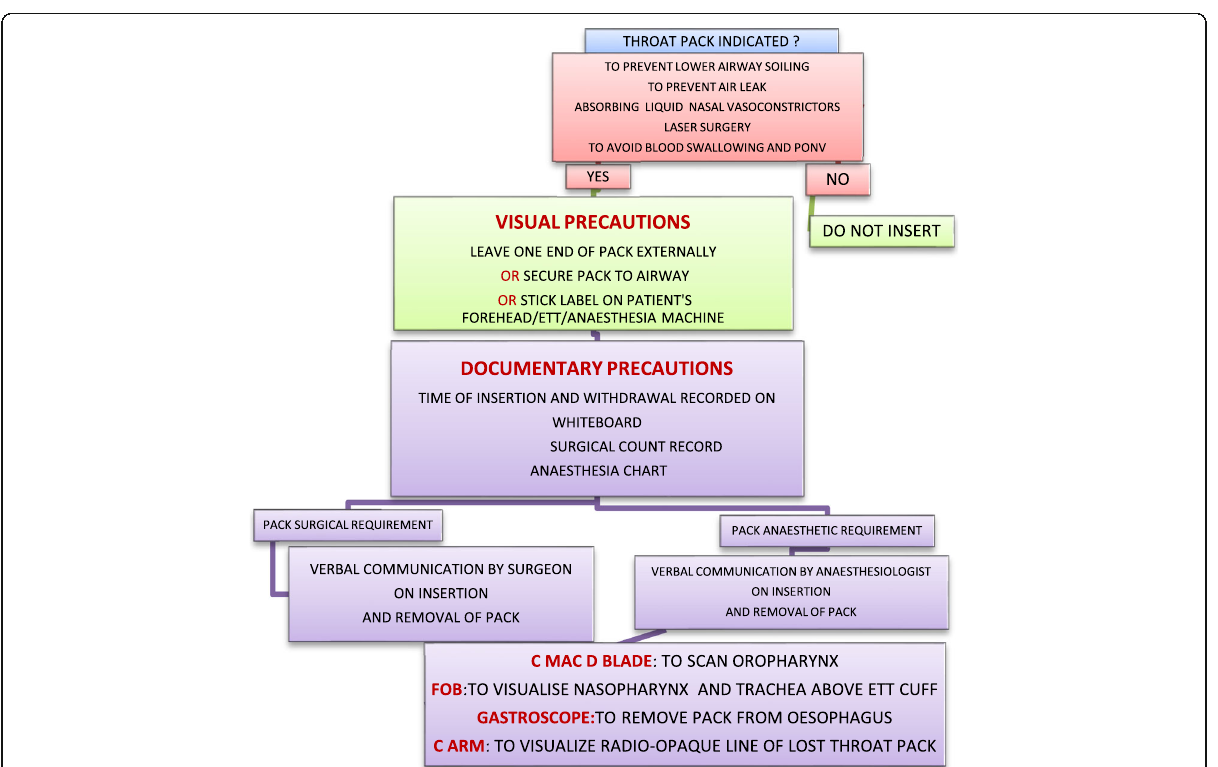
Fig. 2 Algorithm for throat pack insertion and missing throat pack. PONV, postoperative nausea vomiting; FOB, fiberoptic